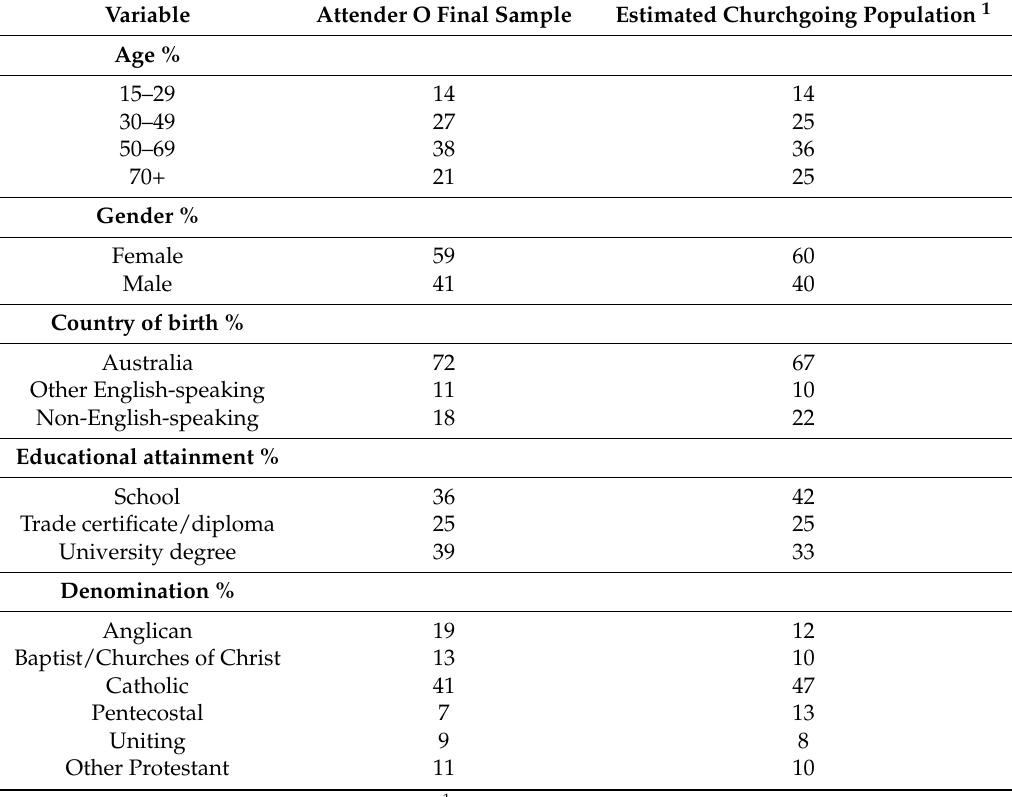
Table 1. Demographics of sample and estimated churchgoing